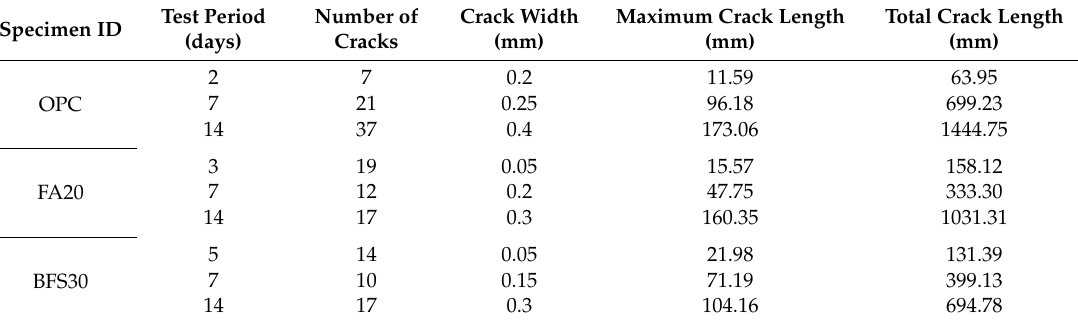
Table 6. Crack properties of concrete specimens (length, width,